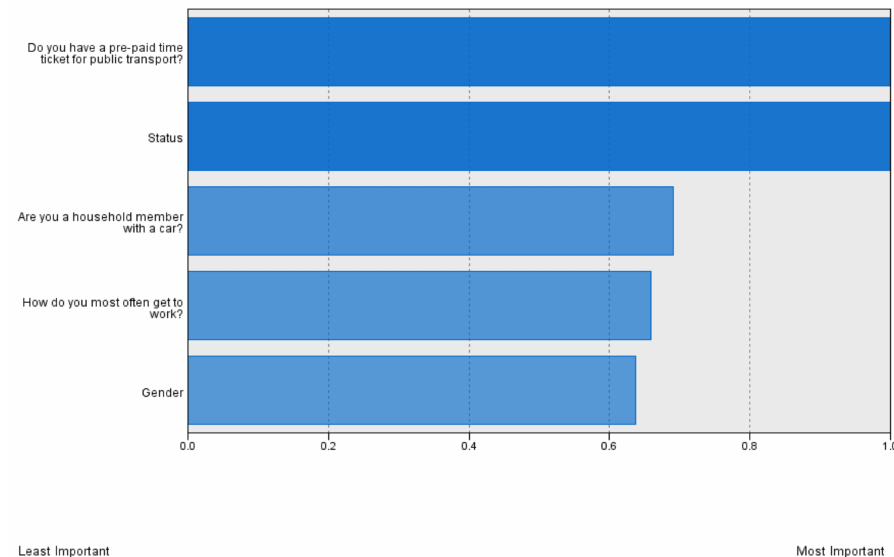
Figure 1. Five important predictors in segmentation in everyday travel behaviour.